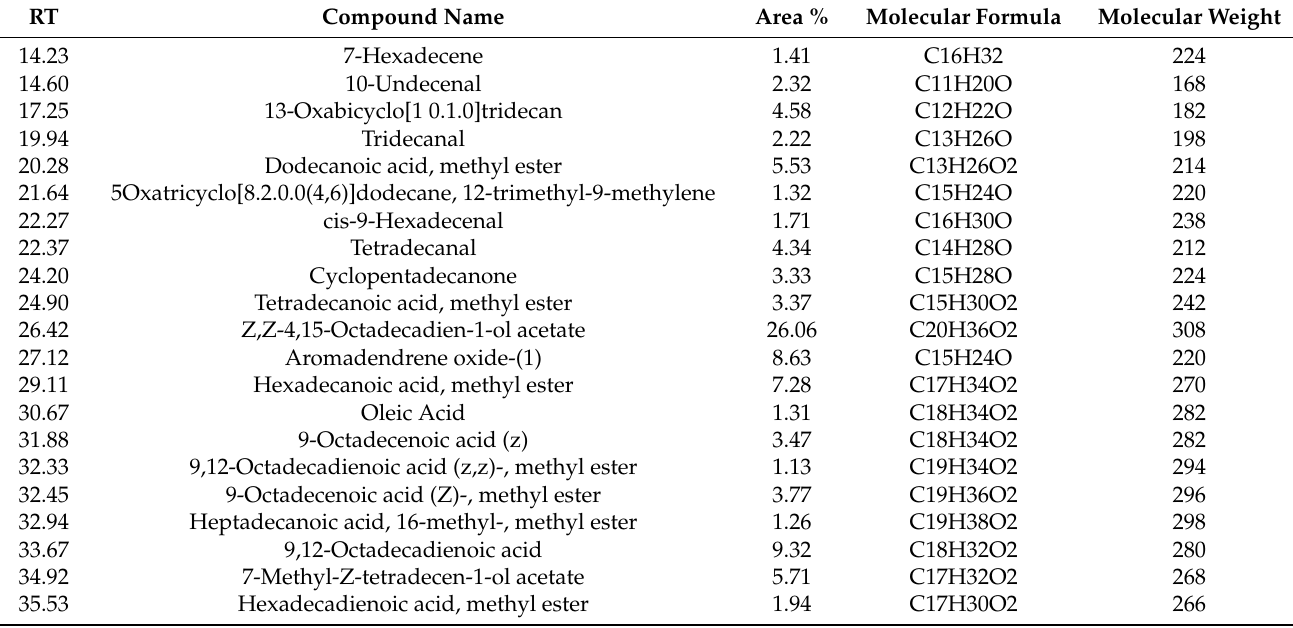
Table 3. Chemical compounds, retention time (RT), and constituents of the avocado seed as detected by